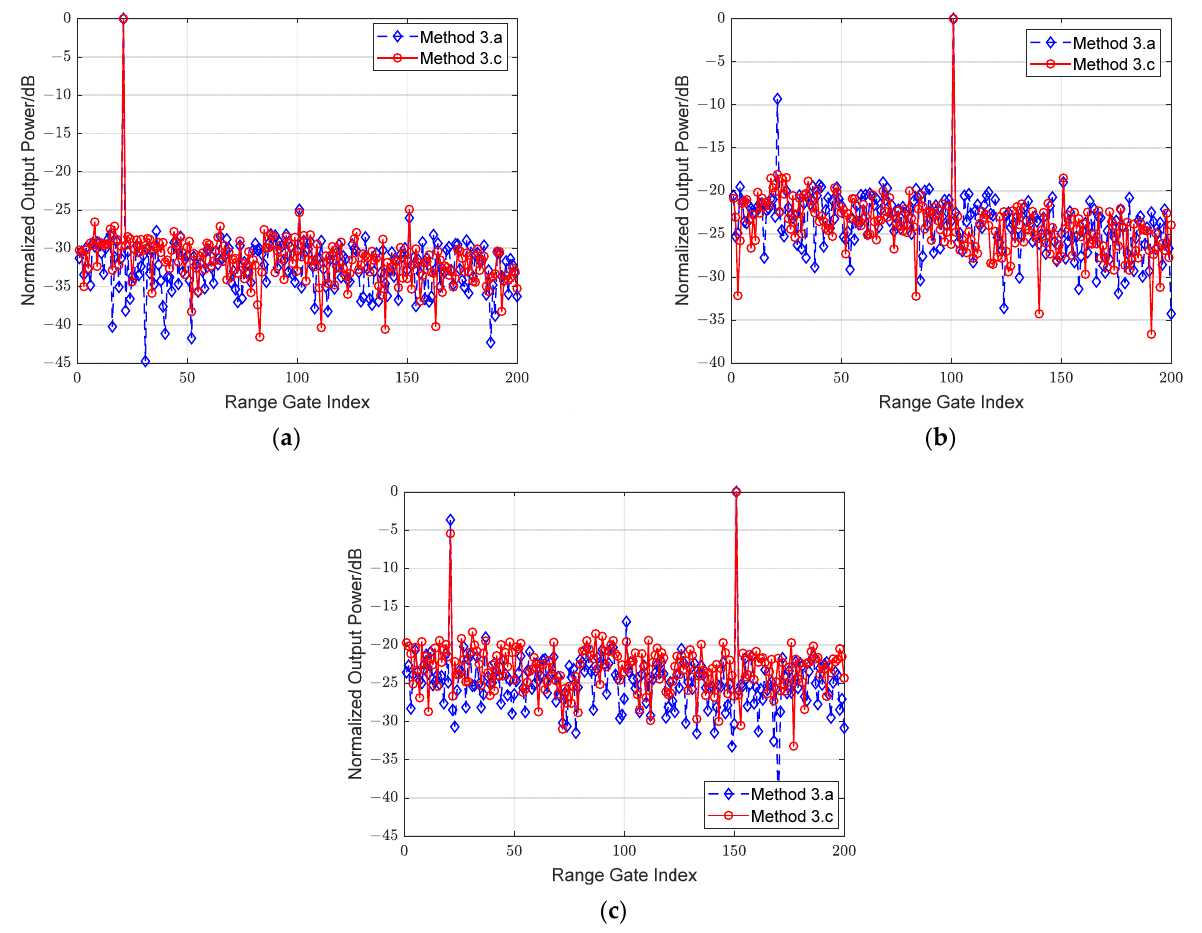
Figure 16. Normalized output power spectrum in different Doppler channels by method 3.a and 3.c: ( a ) Doppler channel of 1st target; ( b ) Doppler channel of 2nd target; ( c ) Doppler channel of 3rd target.